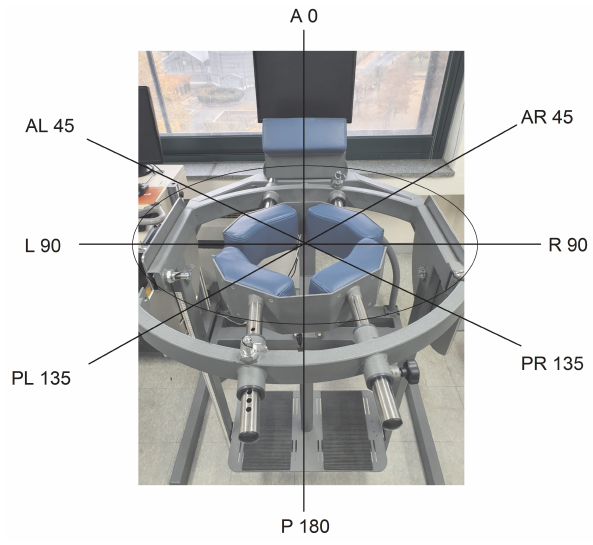
Fig. 1. Core dynamic balance test by Air Balance 3D. The grid displays directional terms. A0, anterior; P180, posterior; L90, left-lateral; R90, right-lateral; AL45, anterolateral left; AR45, an- terolateral right; PL135, posterolateral left; PR135, posterolateral